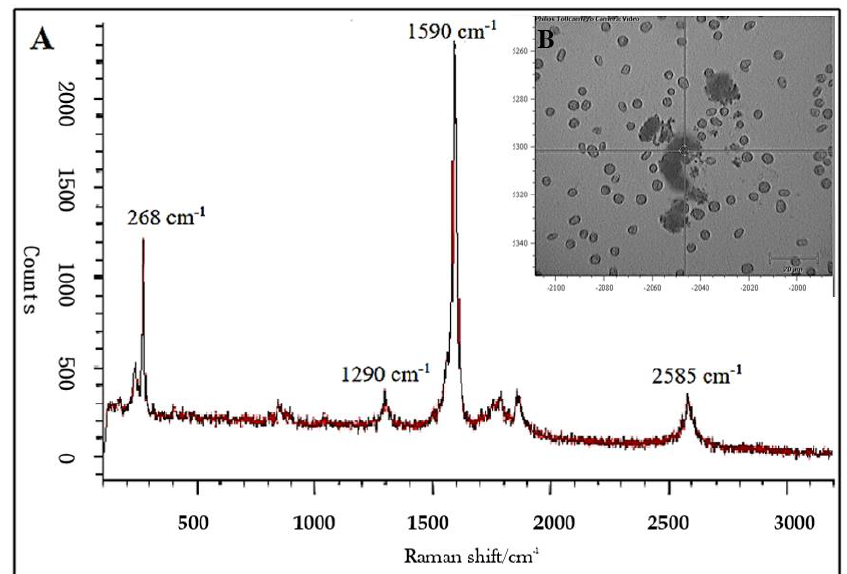
Figure 3. SEM images of T. suecica from control samples ( A ) and from culture medium containing final 500 µg L − 1 SWCNTs ( B ); algae (appear surrounded by SWCNTs agglomerates).